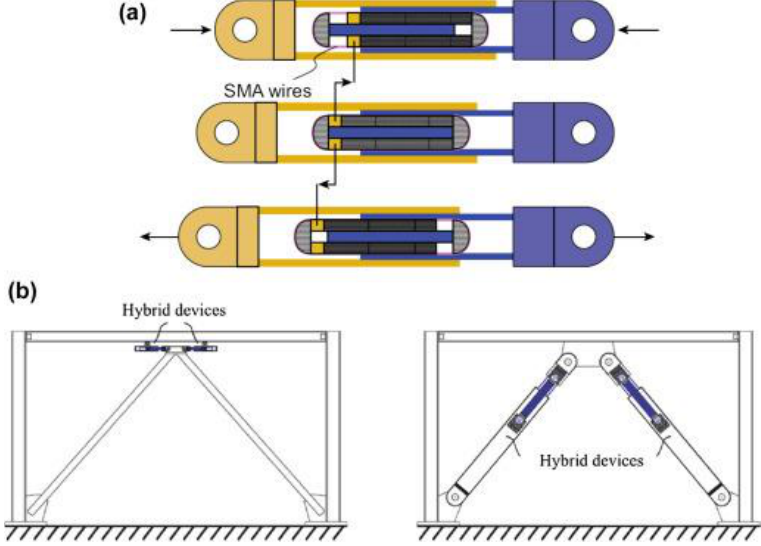
Figure 1. ( a ) Hybrid device with SMA wires and ( b ) different configurations of the proposed device [5]. (Reprinted from Ref. [5], Fig. 21.1, 2021, with permission from Elsevier.)